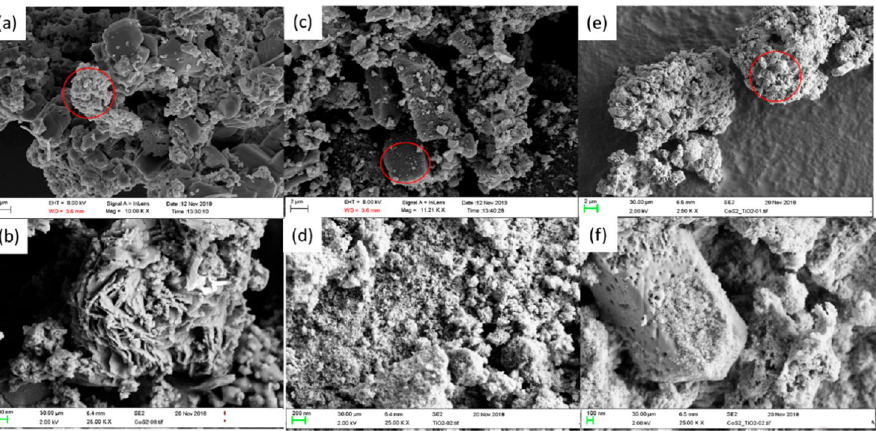
Figure 20. SEM images of ( a , b )—pure CoS 2 , ( c , d )—pure TiO 2 , and ( e , f )—CoS 2 /TiO 2 nanocomposites. Reproduced with permission from